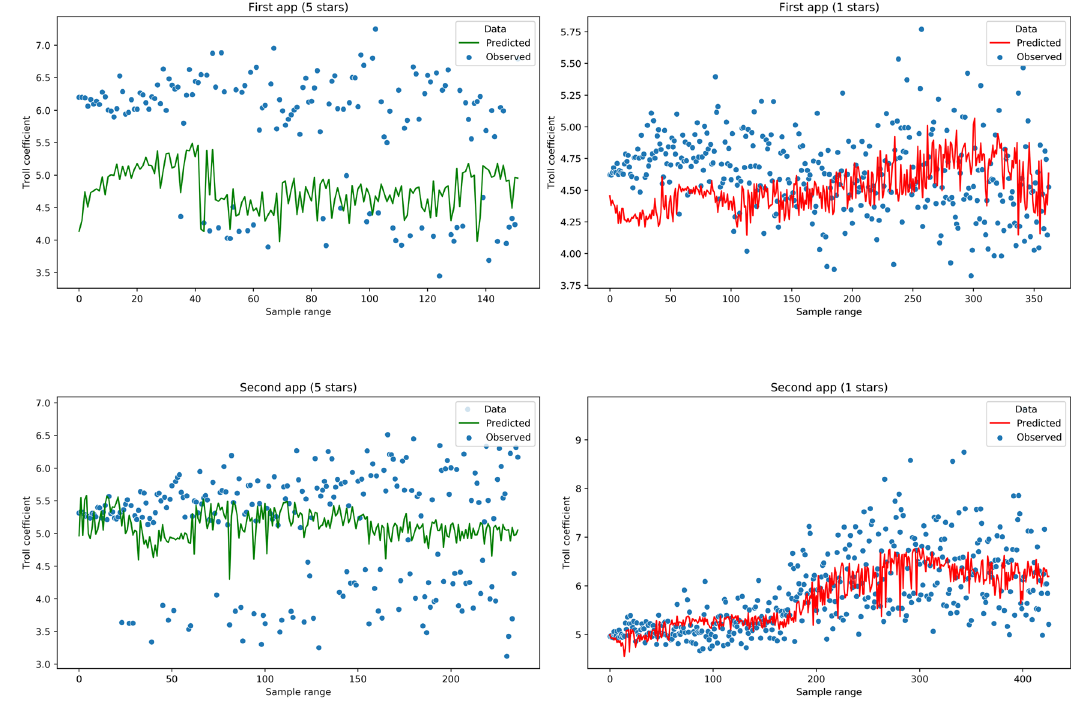
Fig. 8 Observed and predicted values of troll coef fi cients. Five- and one-star reviews of two suspicious